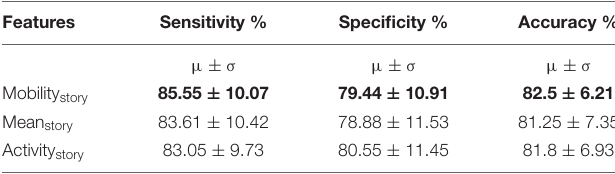
TABLE 4 | Channel classification performance (mean and variance) for individual active task data, using each story independently (training paradigm-III).